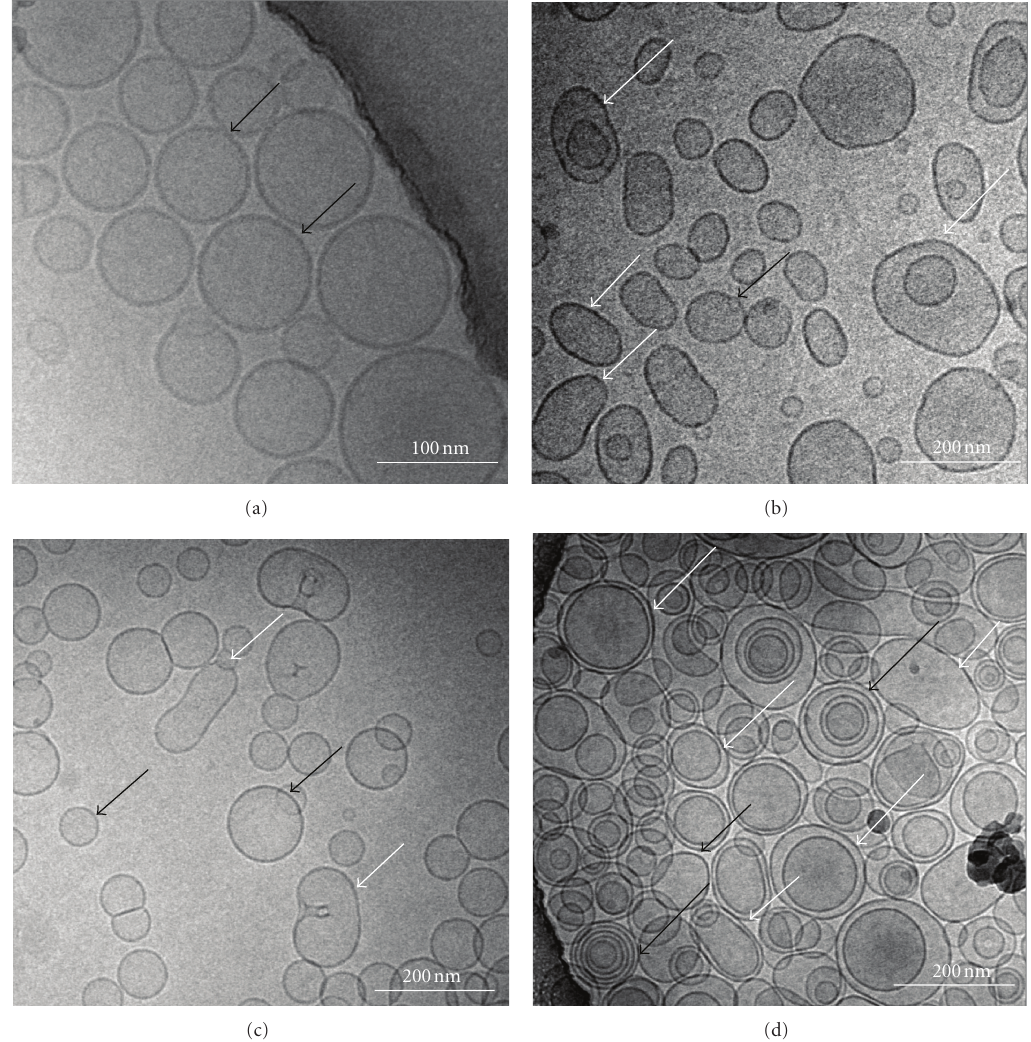
Figure 3: Visualization of CF-loaded liposomes by cryo-electron microscopy. (a) CF-CL, (b) CF-FL1, (c) CF-FL2, and (d) CF-FL3. Black short arrows represent unilamellar vesicles; black arrows of length represent multilamellar vesicles, white short arrows represent deformed vesicles while white long arrows represent bilamellar vesicles.